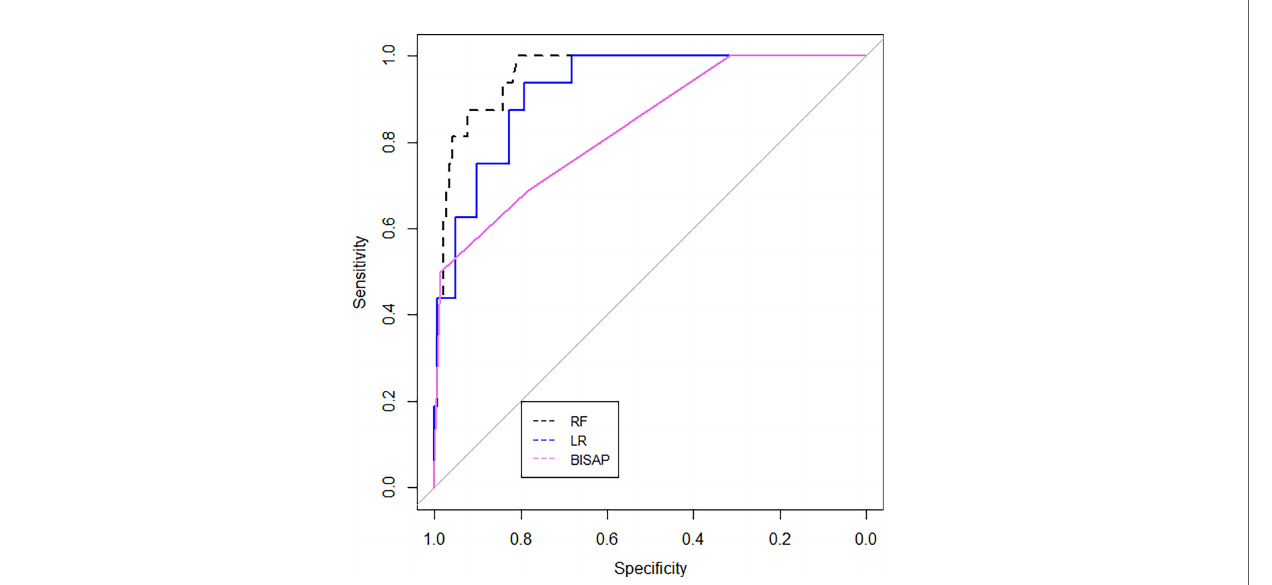
FIGURE 6 | ROC curves for the RF and LR models and BISAP scores, applied on the test